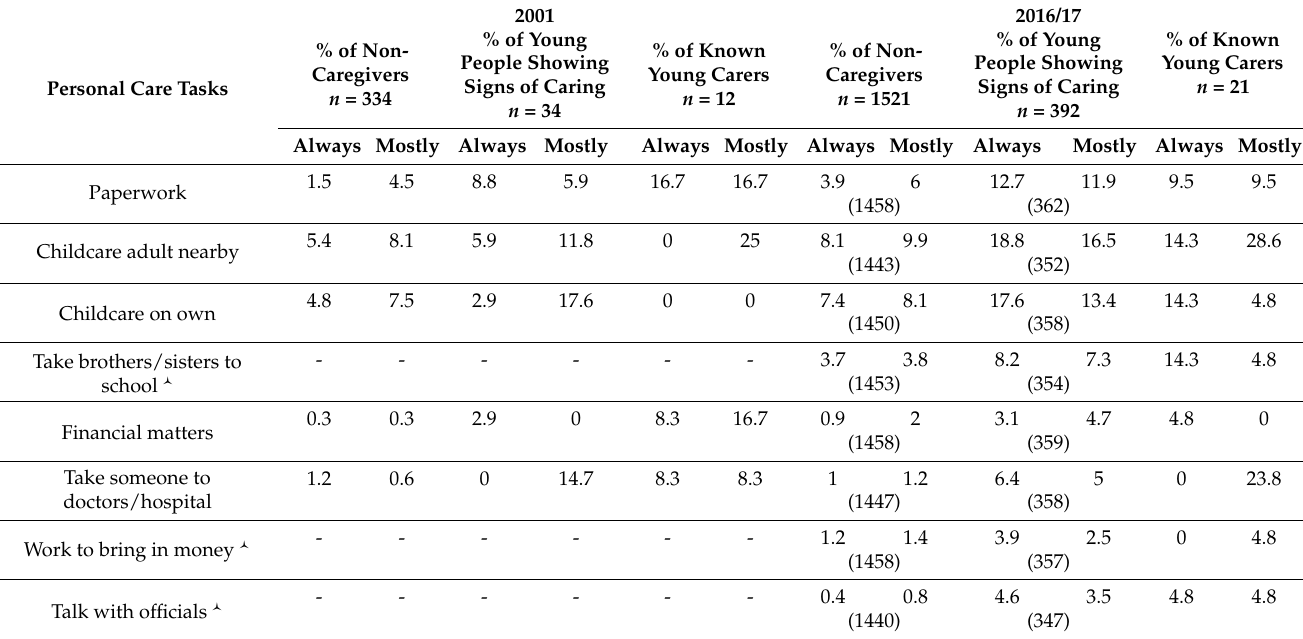
Table 4. Frequency of personal care tasks undertaken by non-caregivers, young people showing signs of caring and known young carers in 2001 and 2016/17.